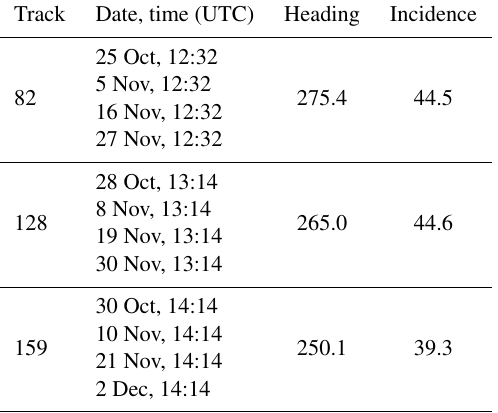
Table 2. Satellite track number and acquisition times as well as scene centre heading (degrees from north) and radar incidence an- gles of TerraSAR-X images acquired over the study period in 2014.